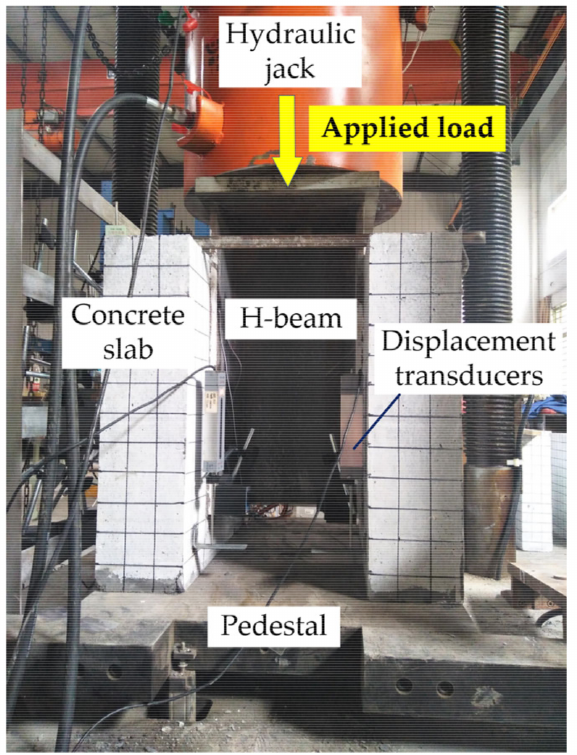
Figure 3. Loading